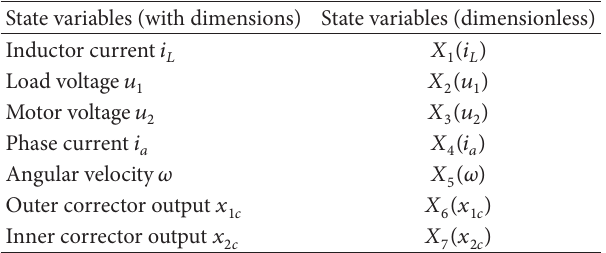
Table 1: Nomenclature for state variables.